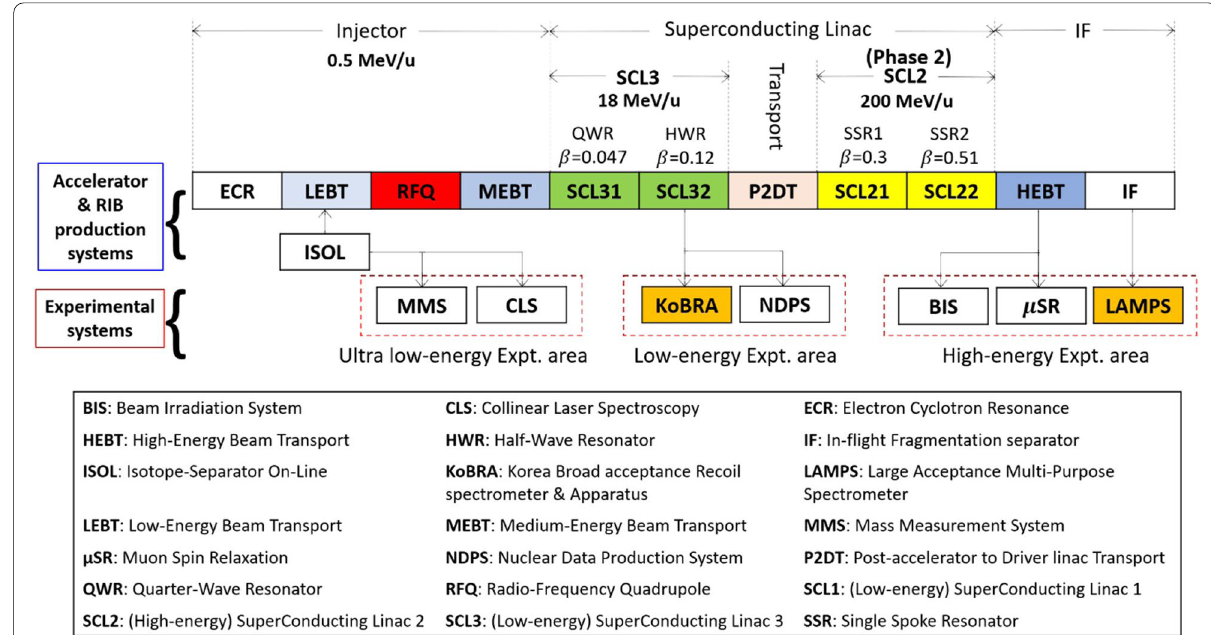
Fig. 2 Schematic of RAON for the accelerator components, RIB production system, and beam extraction positions for seven experimental setups. The bottom table shows the full names of acronyms used in this